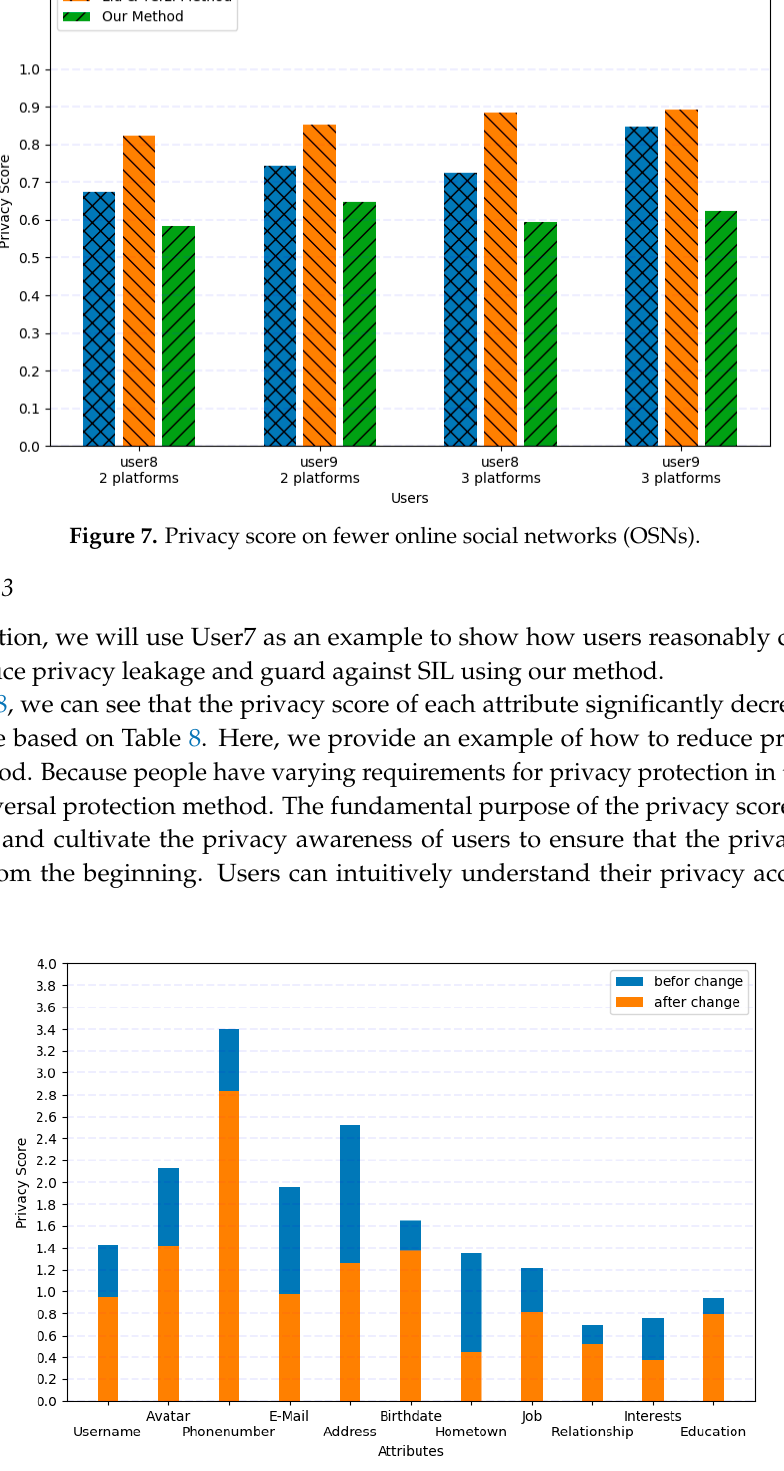
Figure 8. Privacy score after profile changes.